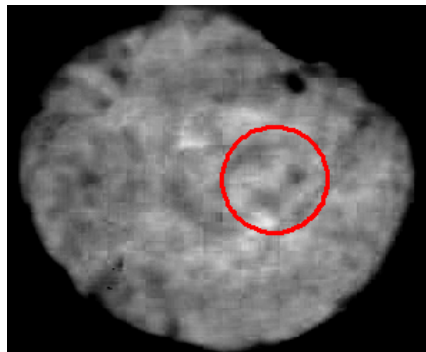
Figure 11. Region of Interest (ROI).